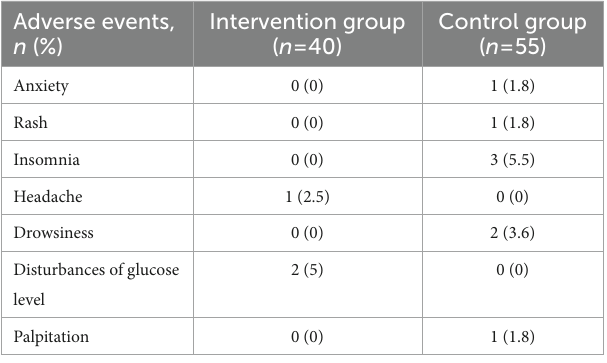
TABLE 4 Adverse events related to